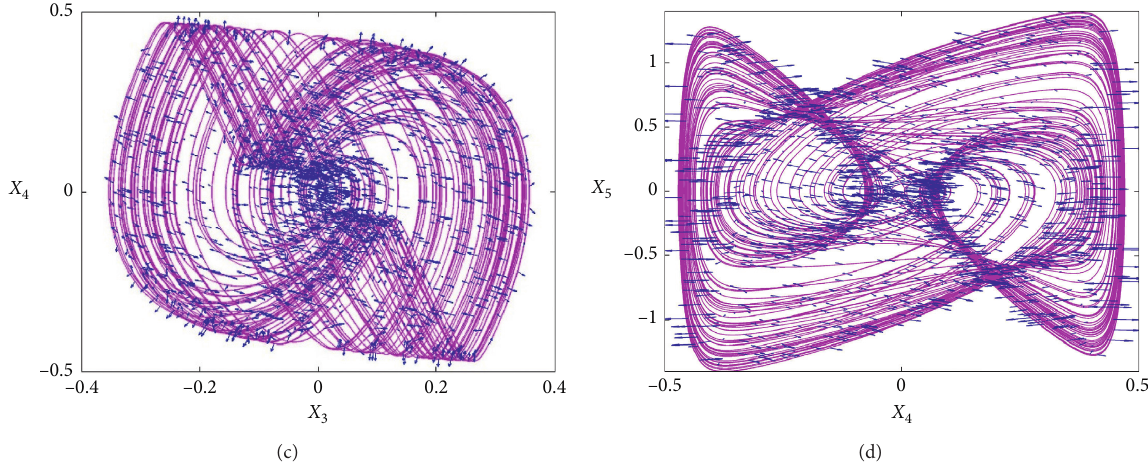
Figure 7: The negative Lyapunov vectors (LE5): (a) first and second components of negative Lyapunov vectors (LE5) in x second and third components of negative Lyapunov vectors (LE5) in x − x plane; (d) fourth and fifth components of negative Lyapunov vectors (LE5) in x vectors (LE5) in x 3 4